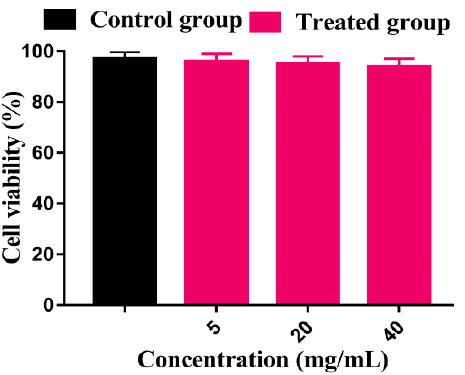
Figure 12. Cytotoxic testing of control and treated groups (CS/CP/PVAcPAa hydrogel).